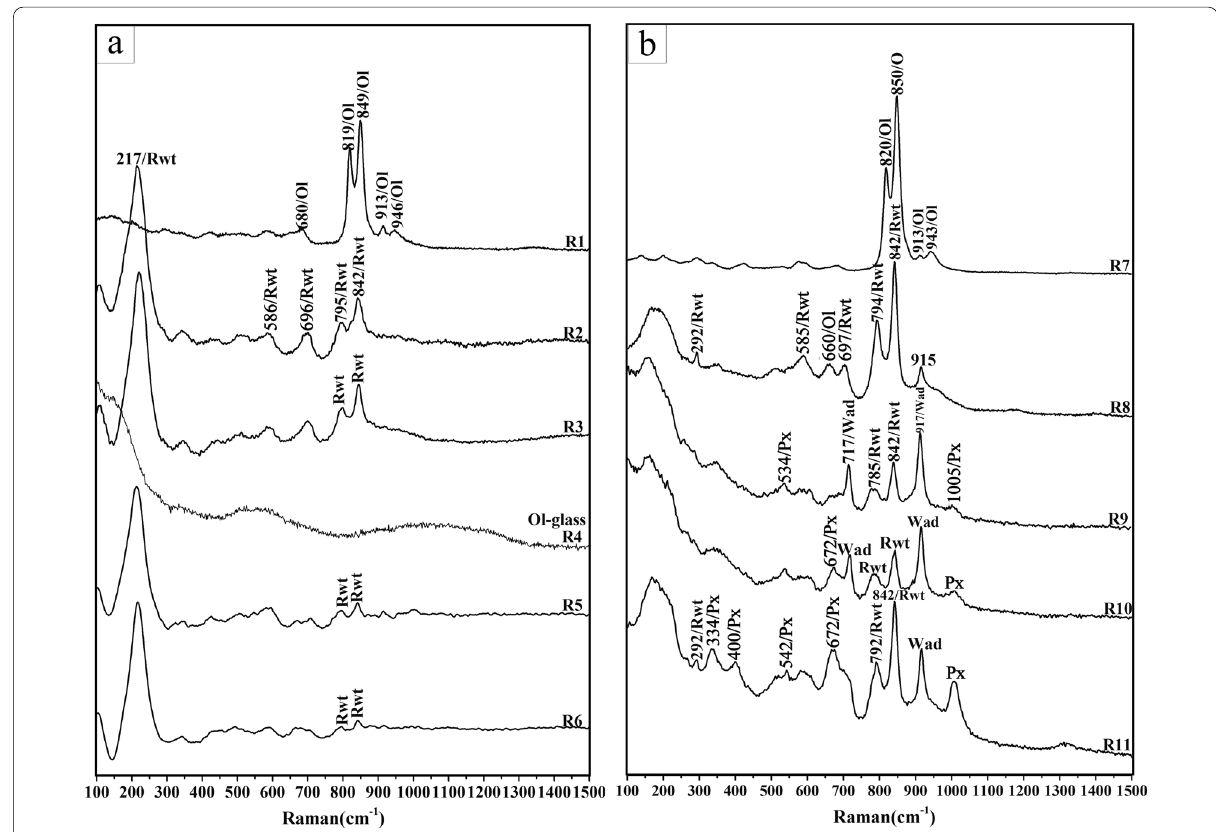
Fig. 3 Raman spectra of various polymorphs of olivine (Ol). a Raman spectra of olivine (R1), lamellar ringwoodite (R2–R3), olivine glass (R4), polycrystalline, and ringwoodite microlite clusters (R5–R6). b Raman spectra of olivine (R7), polycrystalline ringwoodite aggregates (R8), rod-like ringwoodite, wadsleyite, and pyroxene (R9–R11). Wad wadsleyite, Px pyroxene; others are the same as